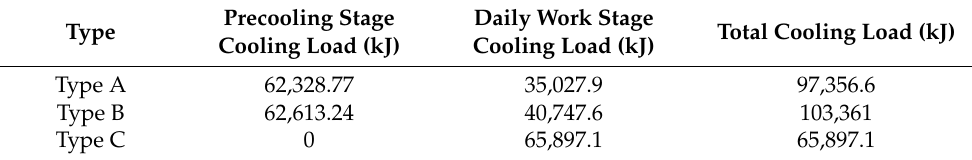
Table 3. Stage cooling